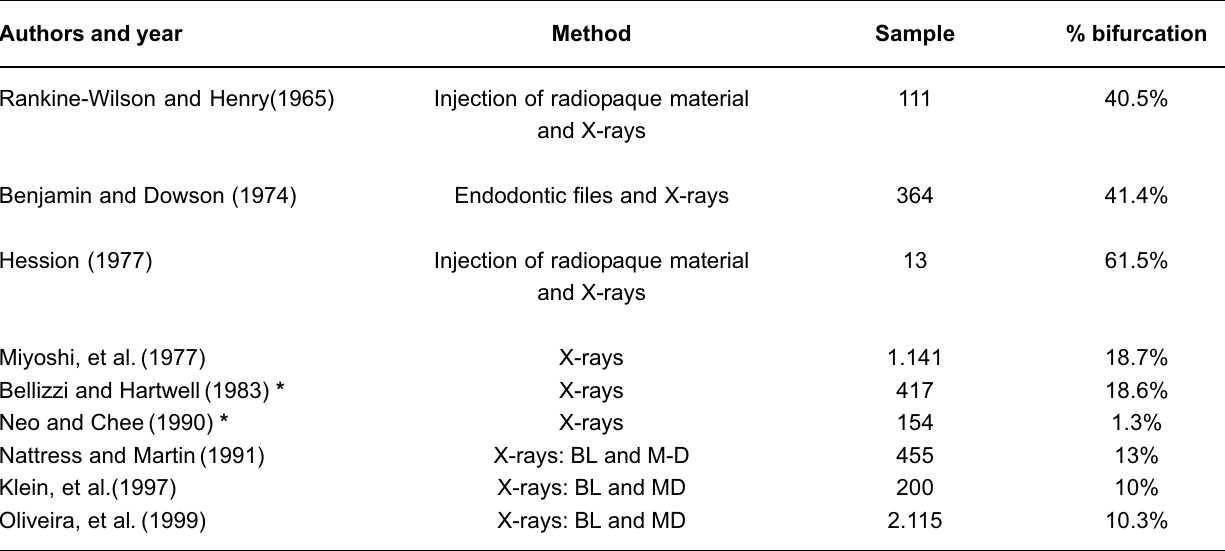
TABLE 1- Radiographic studies of the internal anatomy of mandibular incisors